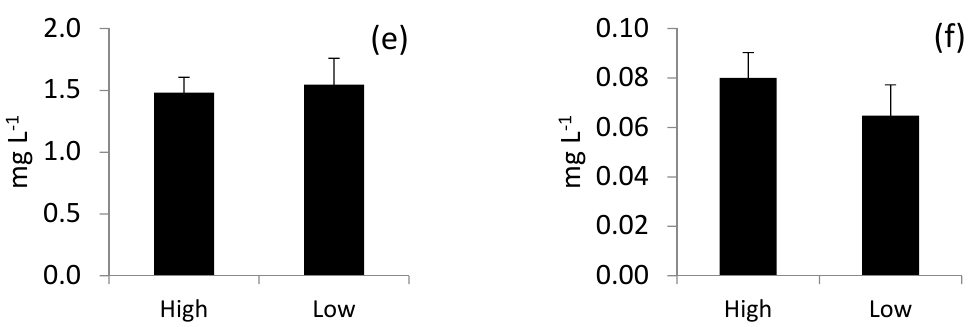
Figure 8. Comparisons of mean values of key parameters between years of above- ( i.e. , high) and below-average ( i.e. , low) water level in Lake George from 1996 to 2010. All comparisons are significantly different ( p < 0.05) except TN. Bars represent one standard deviation.